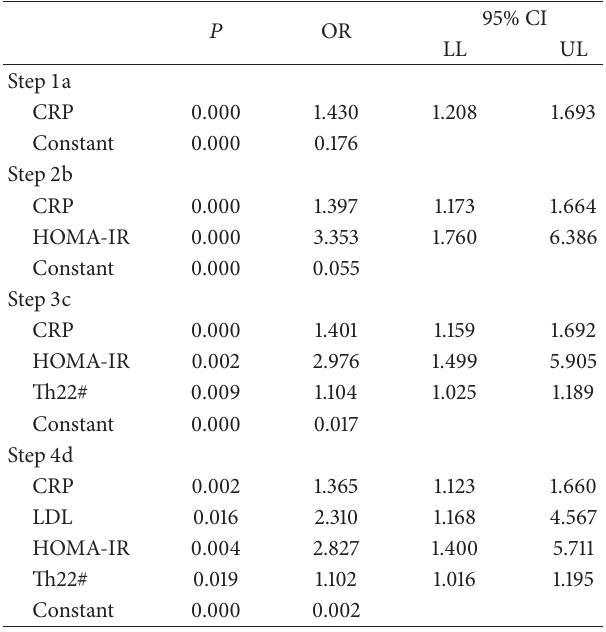
Table 4: Stepwise logistic regression models for independent risk factors